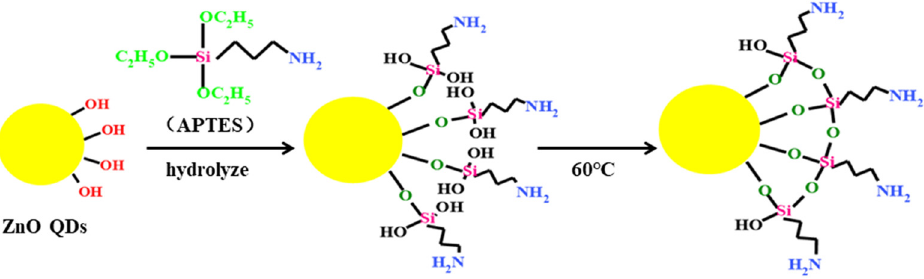
Figure 6: Sketch of the silanization method.